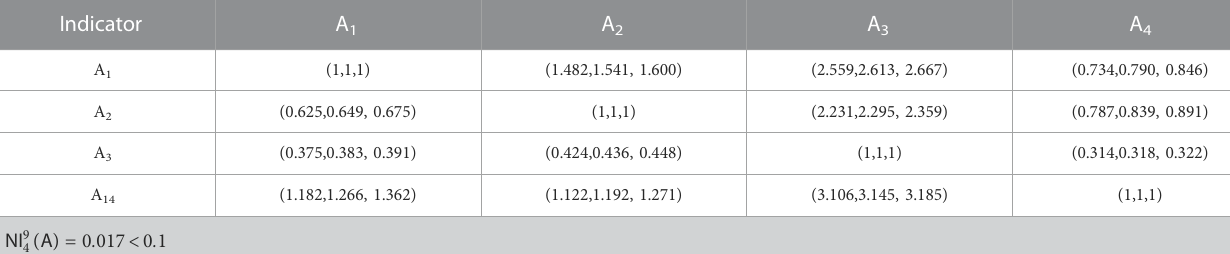
TABLE 5 Pairwise comparison matrix of construction preparation factor layer (MCS-AHP).